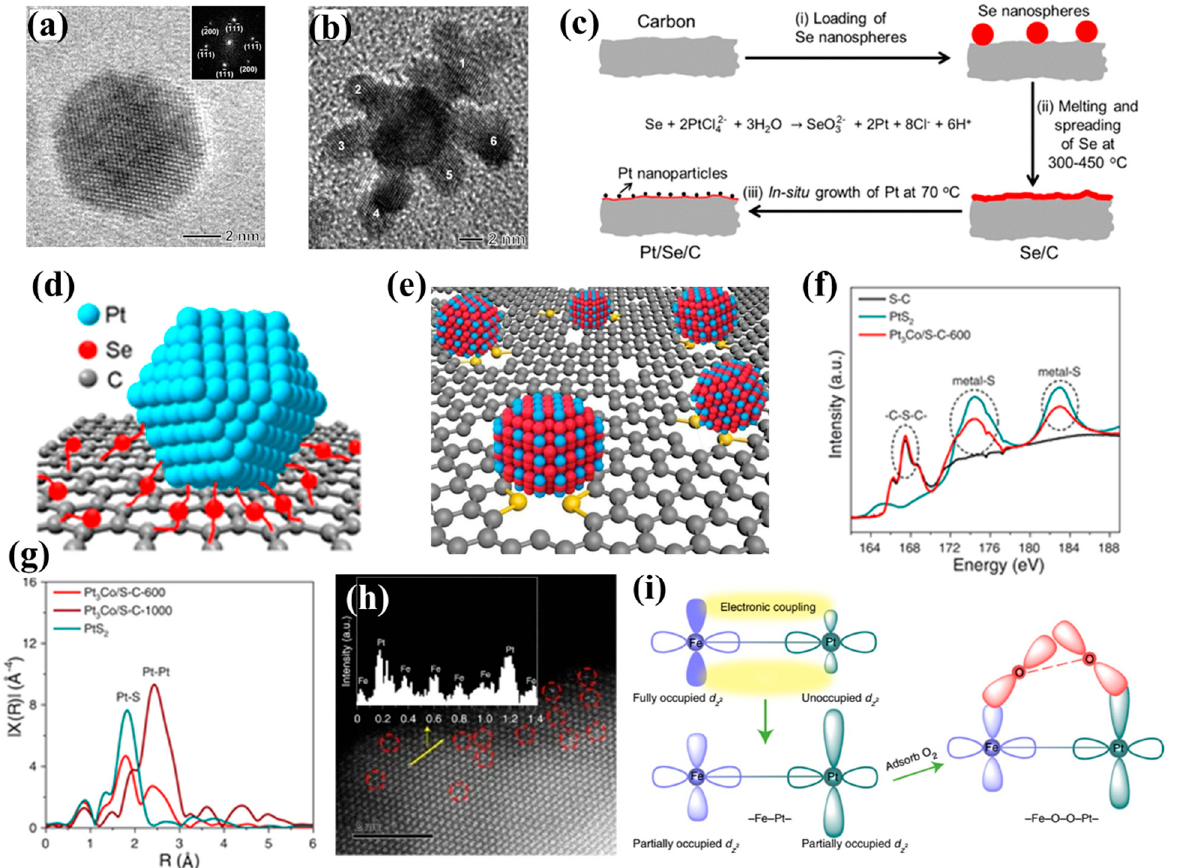
Figure 5. HRTEM image of Pd seed ( a ) and Pd − Pt nanodendrite ( b ). Reprinted with permission from Ref. [20]. Copyright 2009, Science. ( c ) Schematic illustration of a Pt − Se − C catalyst. ( d ) Schematic illustration showing how the Pt particle is anchored to the surface of a carbon support through the Pt − Se − C linkage. Reprinted with permission from Ref. [50]. Copyright 2019, Nano Le tt ers. ( e ) Schematic illustration of the sulfur-anchoring synthetic approach. ( f , g ) XANES spectra and Fourier-transformed EXAFS data indicating the formation of Pt − S bonds. Reprinted with permission from Ref. [10]. Copyright 2021, Science. ( h ) An aberration-corrected HAADF–STEM image of Pt 1 – Fe/Fe 2 O 3 (012), with single–site platinum marked by red dashed circles. ( i ) A schematic diagram of Pt–Fe electronic coupling e ff ect for O 2 activation. Reprinted with permission from Ref. [52]. Copyright 2021, Nature Energy.